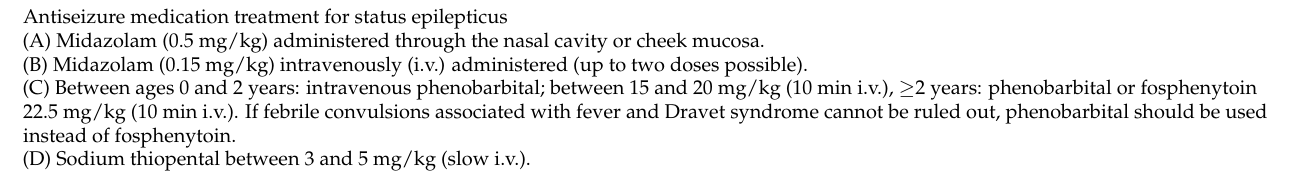
Table 3. Proposed protocol for BHT followed by targeted temperature management (Dokkyo